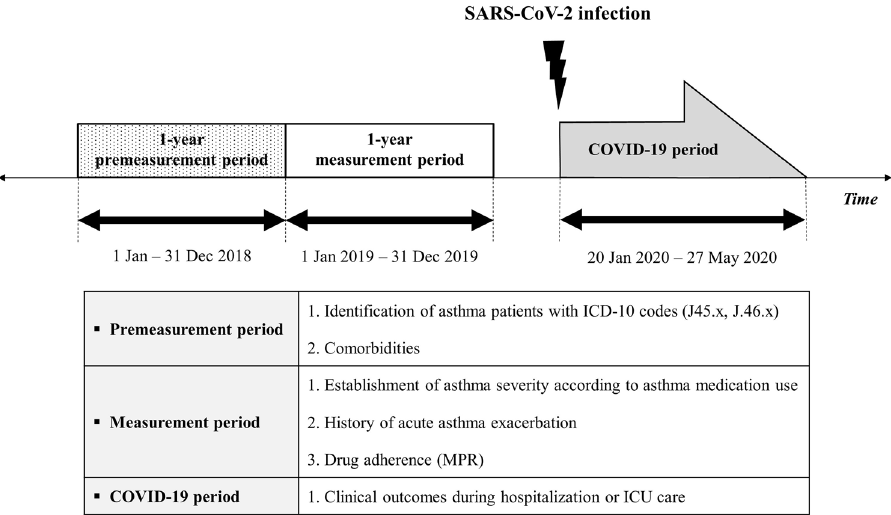
Figure 1. Study scheme. Information on the study population was collected from three different periods: the premeasurement period, measurement period, and coronavirus disease (COVID-19) period. The inclusion and exclusion criteria were adapted, and baseline characteristics of patients were assessed during the premeasurement period. Asthma severity, number of acute exacerbation(s), and medication possession ratio were evaluated during the measurement period. COVID-related morbidities and mortalities were evaluated during the COVID-19 period. COVID-19, coronavirus disease; SARS-CoV-2, severe acute